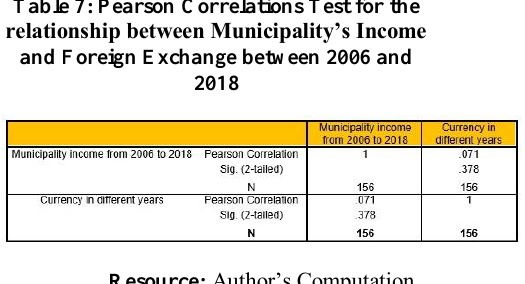
Table 4: Checking the Mann Variables